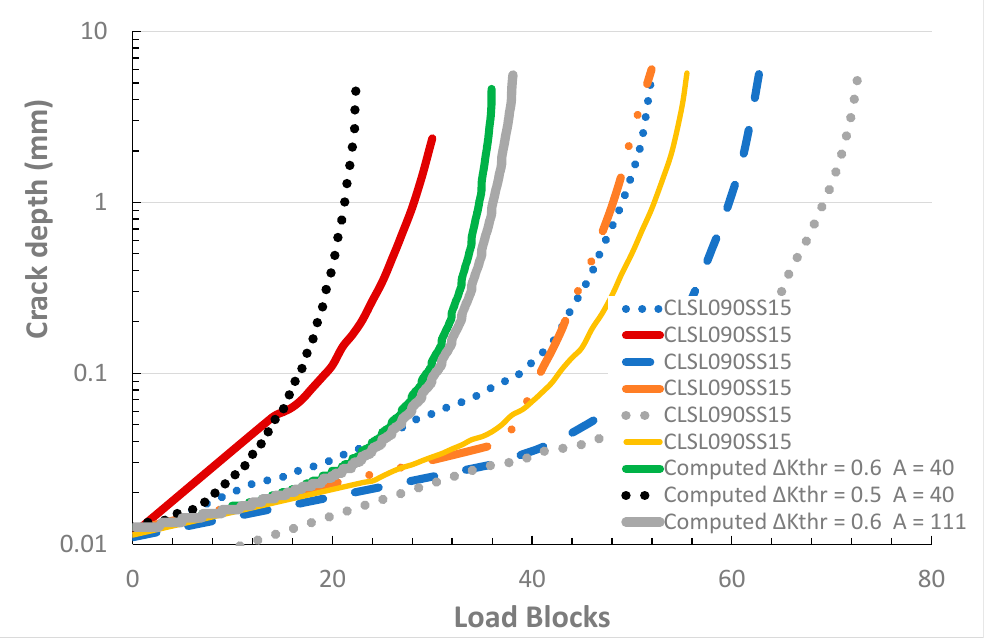
Figure 11. The measured and computed crack depth histories for the helicopter flight load spectrum CLS0900SS15.